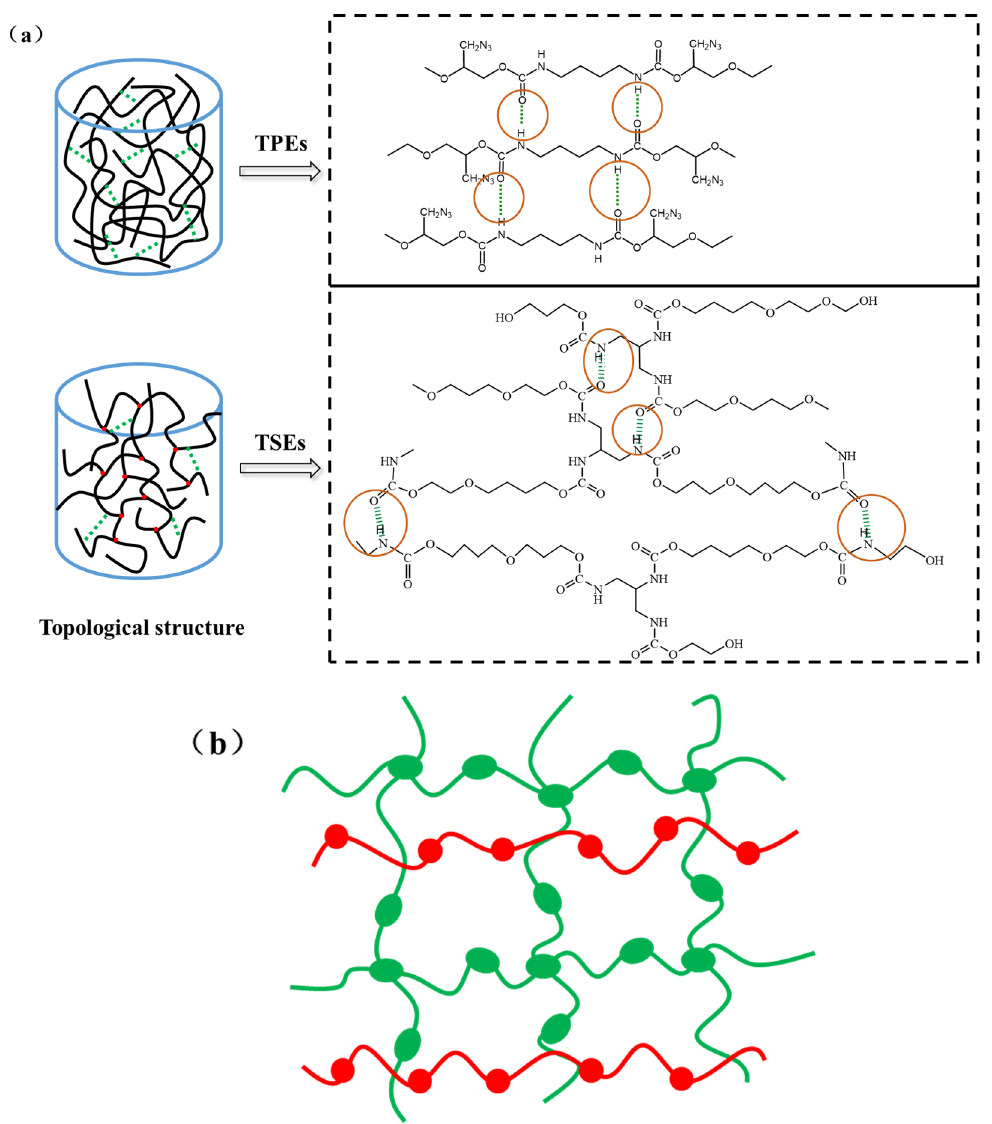
Figure 1. The diagram of network structure for polymers. ( a ) TPEs and TSEs (green imaginary line expresses the intermolecular hydrogen bond (marked by the red circle); red dot expresses the crosslinking point); ( b ) Basic combinations of two polymers for semi-IPN.